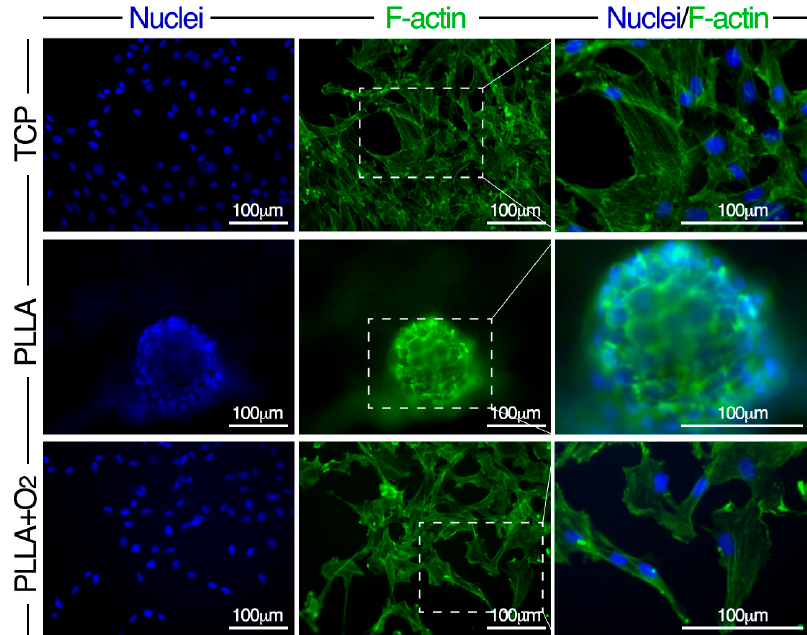
Figure 3. Morphology of hASCs on PLLA and on PLLA+O 2 cultures. Representative fluorescence images of nuclei (DAPI, blue) and F-actin (Phalloidin-FITC, green) in hASCs on TCP, on PLLA, and on PLLA+O 2 . High magnification of selected dashed squares (merged DAPI-Phalloidin) is reported in the right panel.